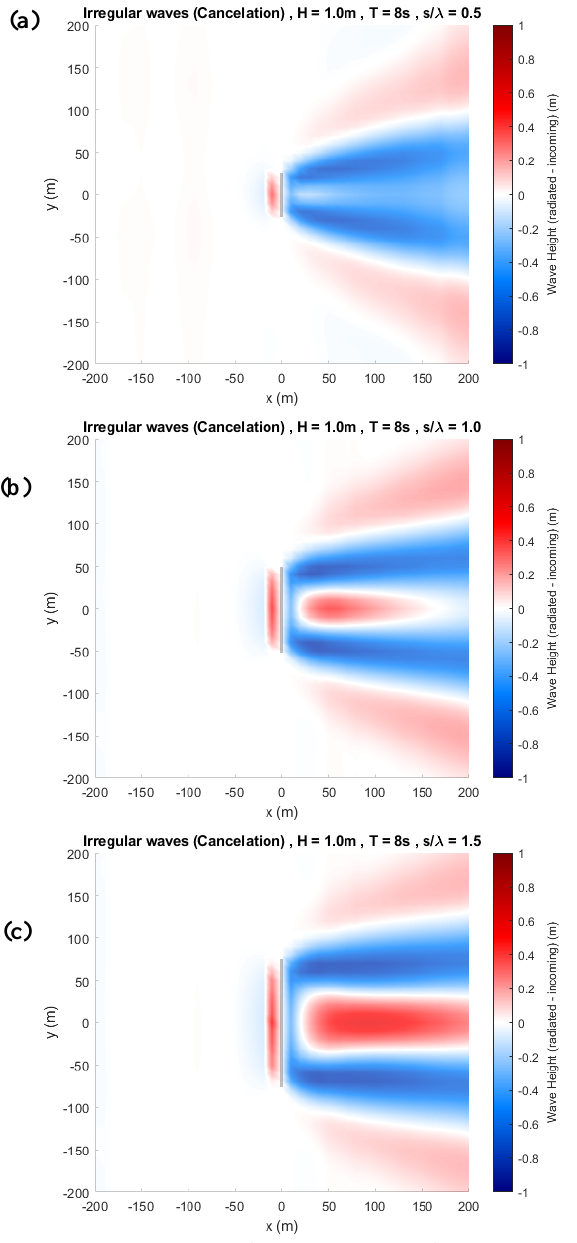
Figure 8: The wave height of the resulting (cancelation) wave field assuming regular wave condition for different spans, (a) 𝑠 𝜆⁄ =